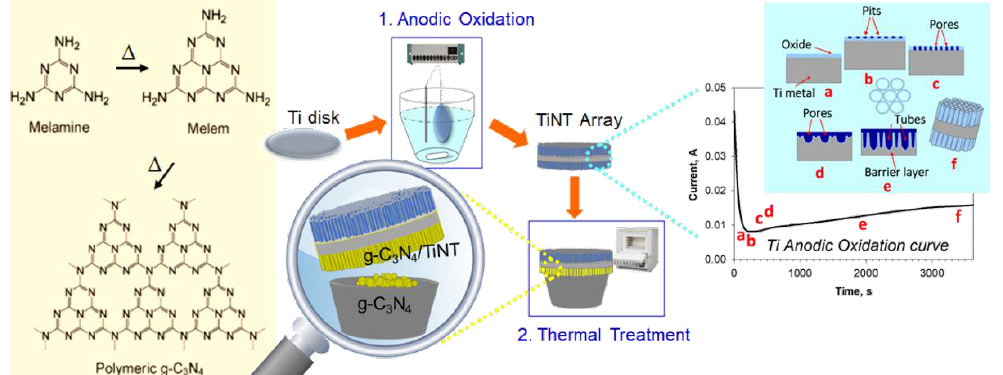
Figure 1. Scheme of the two-step g-C 3 N 4 /TiNT hetero-structures preparation [38]. A typical J-t curve recorded during anodic oxidation is shown in the insert on the left, along with the major changes ( a – f ) occurring in the metal substrate of Ti. On the left is the high-temperature self-polymerisation pathway of g-C 3 N 4 from melamine.